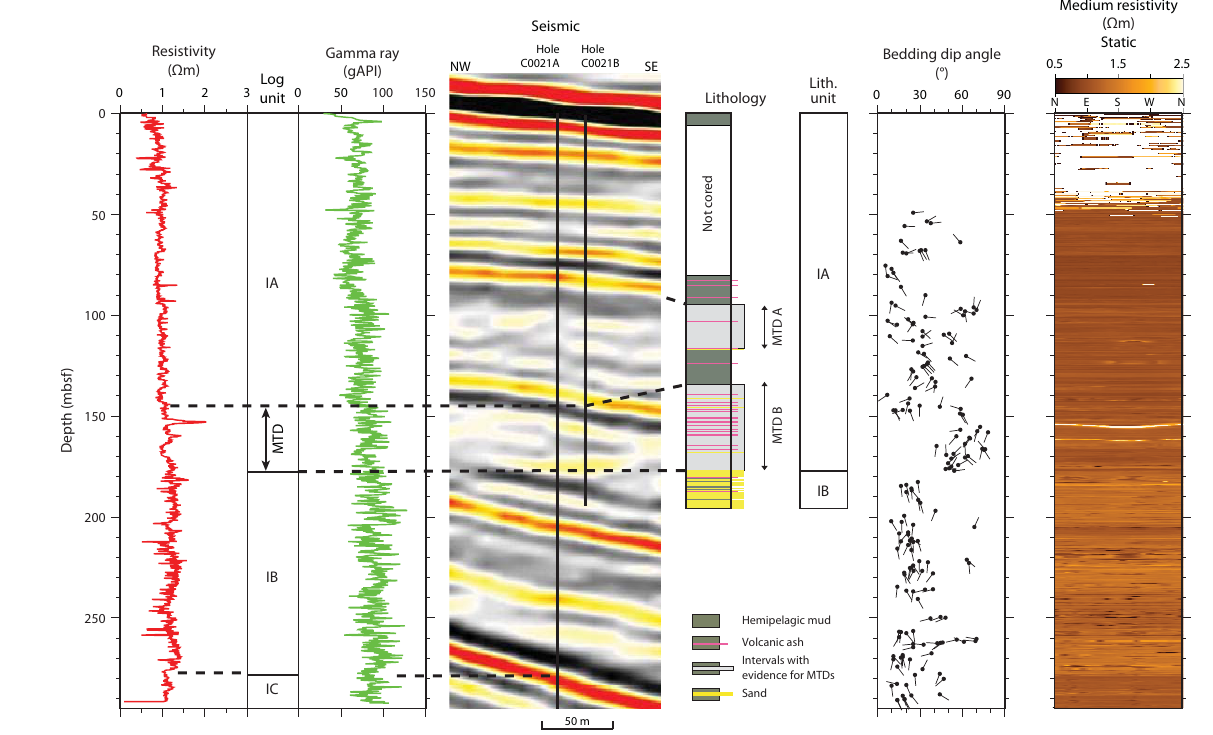
Figure 9. Core-log-seismic integration at Site C0021: LWD data, lithology with mass transport deposit (MTD) intervals and lithologic units, seismic data from In-line 2270 (Kumano 3-D PSDM volume; Moore et al., 2009), bedding dips, and medium button static resistivity.